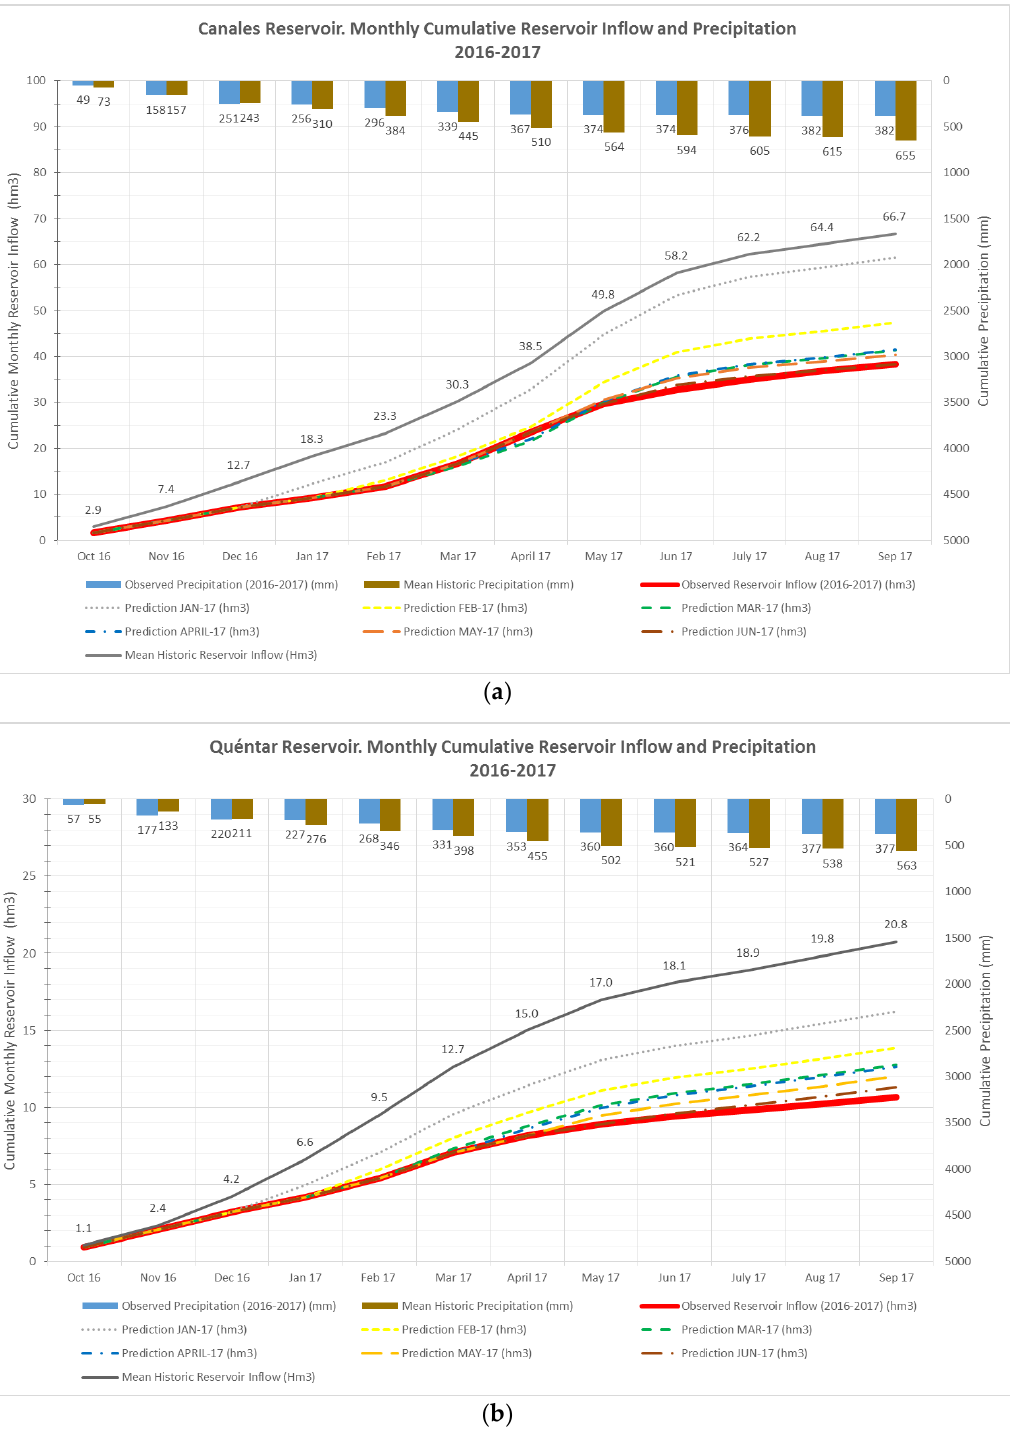
Figure 12 . Predictions of annual and monthly cumulative streamflow (hm 3 ) and observed annual and monthly cumulative streamflow (hm 3 ) of the ( a ) Canales reservoir and ( b ) Quéntar reservoir.